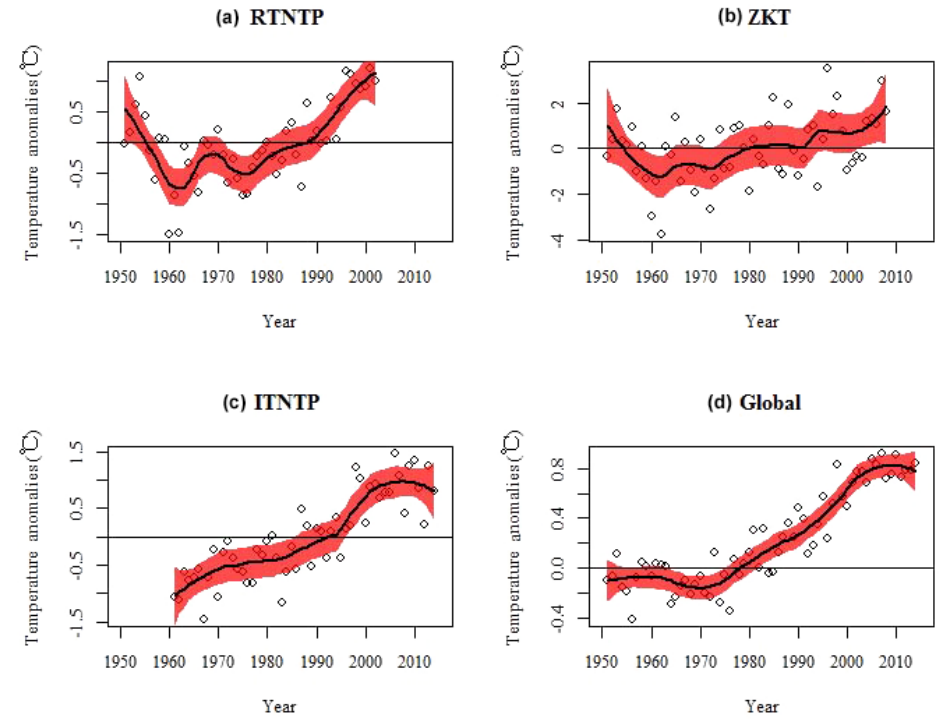
Figure 5. The reconstructed regional temperature series for the northern Tibetan Plateau (RTNTP) from ZK, Muztagata, Puruogangri, and Geladaindong ice core δ 18 O records (a) , the reconstructed temperature series from the ZK ice core δ 18 O record (b) , the instrumental temperature record for the northern TP (ITNTP) (c) , and global average temperature (d) . Black trend lines were estimated using the non- parametric LOESS regression technique with a span of 0.4; the dots indicate the raw values of corresponding temperature series; shading represents the 95% confidence intervals of the estimated trends.